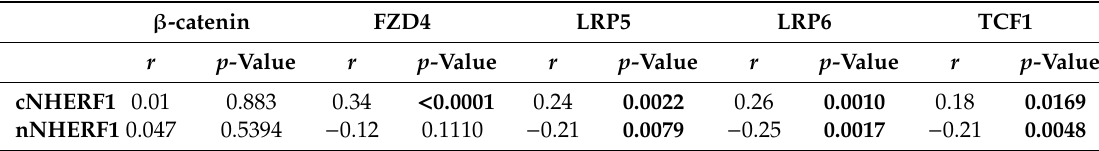
Table 2. Spearman for rank-based correlations between protein expression in BC (breast cancer) patients on continuous